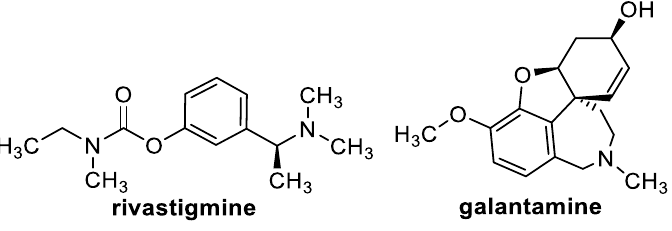
Figure 1. Structures of approved drugs used as standards in this work.